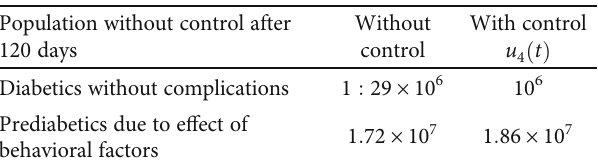
Figure 5: The evolution of the number of diabetics without complications with control u Table 5: Evolution of number of diabetics with control u 120